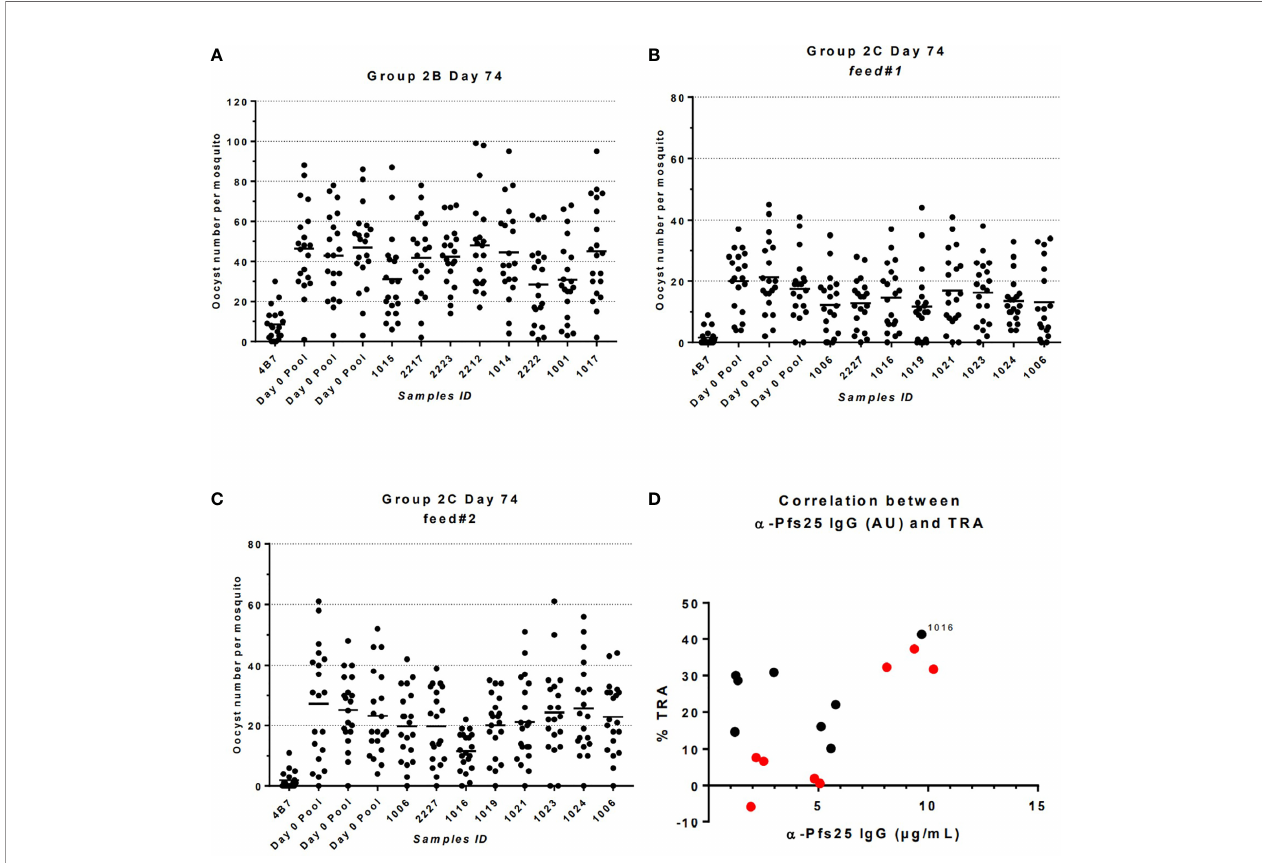
FIGURE 6 | Transmission-reducing activity (TRA) in Groups 2B and 2C as measured by standardized membrane feeding assay. (A) Transmission-reducing activity of IgG from individuals of Group 2B. (B, C) Transmission-reducing activity of IgG from individuals of Group 2C. (D) Correlation between anti-Pfs25 speci fi c IgG concentrations and TRA in individual of Groups 2B (in red) and 2C (in black); subject ID showing signi fi cant transmission-reducing activity is indicated. Total IgG was puri fi ed from D72 serum from volunteers vaccinated with ChAd63/MVA expressing Pfs25-IMX313. The puri fi ed IgG (15 mg/mL) was mixed with P. falciparum NF54 cultured gametocytes and fed to A . stephensi mosquitoes (n=20 per test group) in SMFA. Midguts were dissected 7 days post-feeding. A pool of D0 vector immunized Group 2C volunteers was used as negative